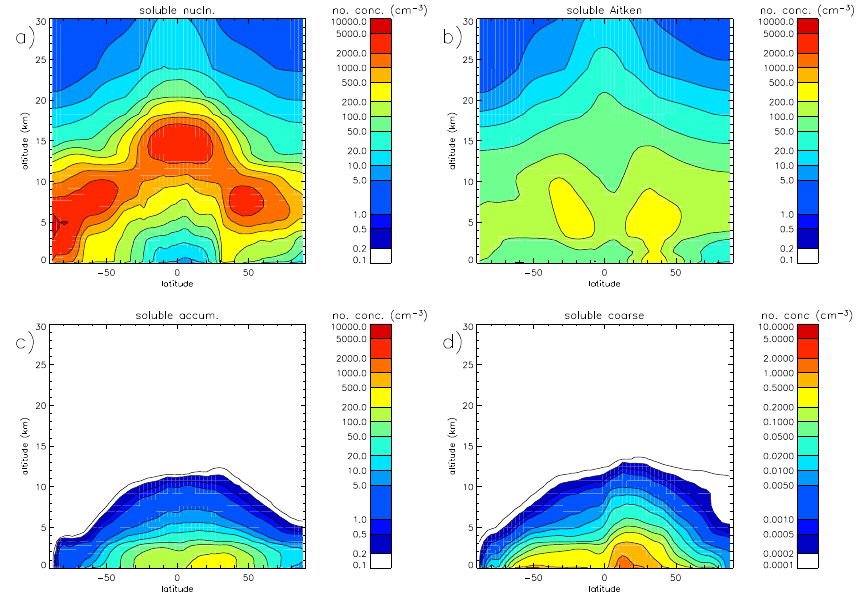
Fig. 13. Latitude-altitude plots of simulated zonal-means of annual-mean particle number concentrations for (a) nucleation mode, (b) Aitken-soluble mode, (c) accumulation-soluble mode and (d) coarse-soluble mode.